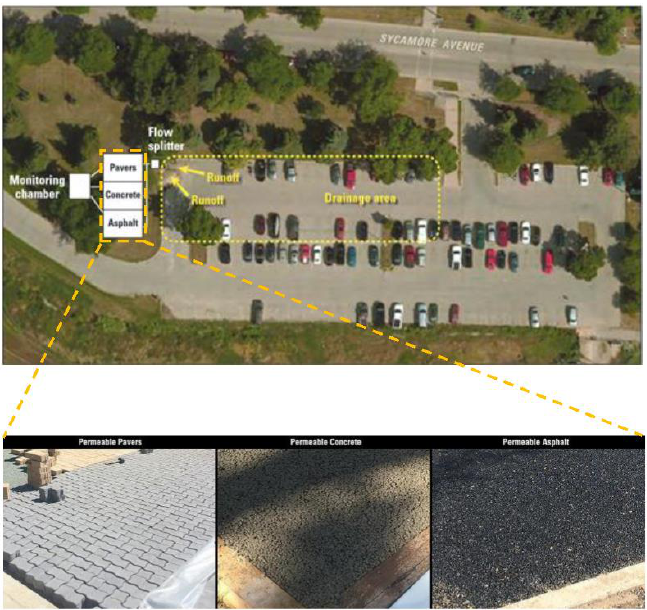
Figure 3. Permeable pavement consisting of permeable asphalt, permeable concrete, and permeable pavers at the outlet of Parking lot located in Madison, Wisconsin [38].